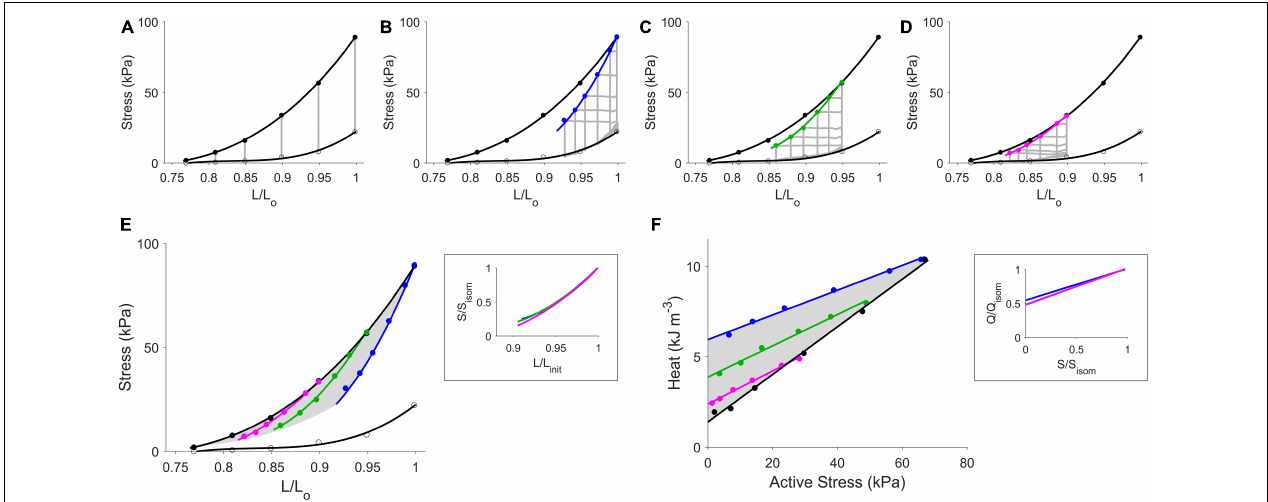
FIGURE 3 | Steady-state data from a representative trabecula superfused with Tyrode solution and isoproterenol. Figure caption is the same as that in Figure 2 . In panel (A) , the isometric end-systolic stress-length relation (upper thick line) and the isometric passive stress-length relation (lower thick line) have been fitted to the six isometric contractions (gray lines) at end-systole (black circles) and at end-diastole (open circles), respectively. These two relations have been transcribed to panels (B–E) . The work-loop end-systolic stress-length relation, obtained by fitting to the end-systolic points (filled circles), is dependent on the initial length (lines: blue, green, and magenta, respectively): at L o (B) , 0.95 L o (C) , and 0.90 L o (D) . In panel (E) , all stress-length relations are superimposed, where the shaded area indicates the zone of the end-systolic points as interpolated using the self-normalized work-loop stress-length relations in the inset, in which L init refers to the three initial muscle lengths ( L o , 0.95 L o , and 0.90 L o ). In panel (F) , the shaded area indicates the zone of the heat-stress relations obtained from the three preloaded work-loop contractions and the isometric contractions. The inset shows the three relations between work-loop heat (Q) and stress (S) normalized to their isometric values (subscripted as “isom”).